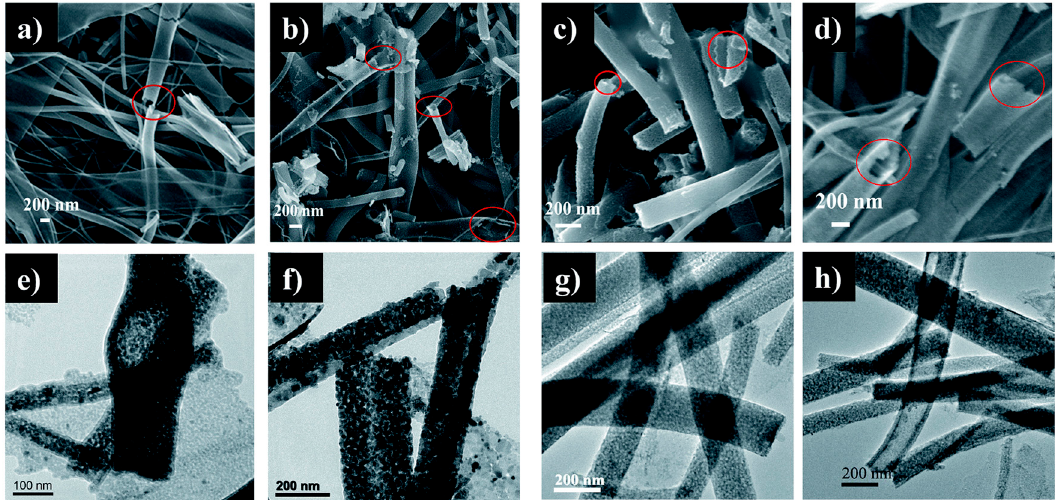
Figure 4. FESEM images ( a – d ) of CdS loaded TiO 2 hollow nanofibers after different successive ion layer adsorption and reaction (SILAR) cycles (1, 2, 3, and 5), respectively (hollow morphologies of nanofibers can be seen in circular markings); and their TEM micrographs ( e – h ). Reproduced with permission from [18]. Copyright 2016, Royal Society of Chemistry.